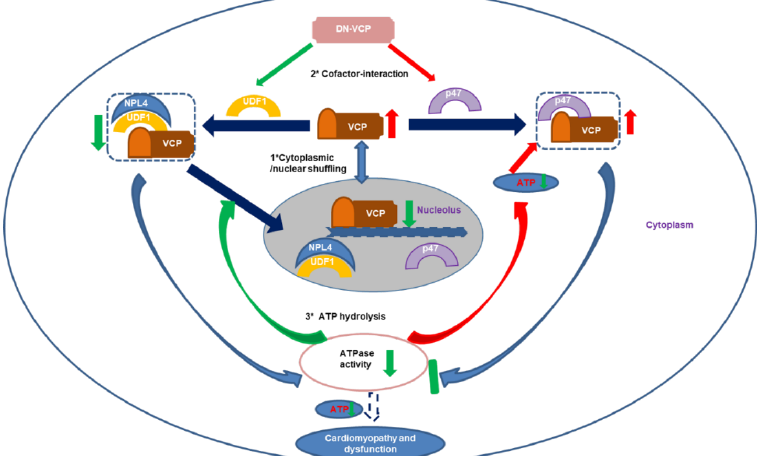
Figure 6. The summary of the findings: The results indicate that dominant-negative VCP (DN-VCP) acts as a dominant-negative mutation inhibiting VCP function in the mouse hearts through a comprehensive mechanism by impairing the endogenous VCP (EN VCP) and its co-factors cytoplasmic/nuclear shuffling, interfering EN-VCP-cofactor binding preference, and repressing ATP hydrolysis, resulting in a progressive dilated cardiomyopathy and dysfunction during the aging transition. Blue arrows: regular biological effects; Red arrows: increase or activating; Green arrows; decrease or inhibiting. UFD-1: ubiquitin fusion degradation protein 1; NPL-4: nuclear protein localization protein 4.